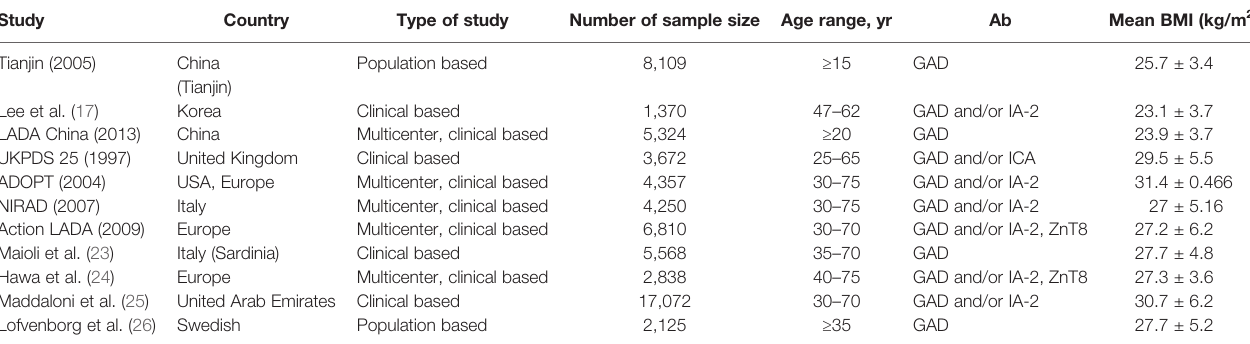
TABLE 1 | The mean body mass index of